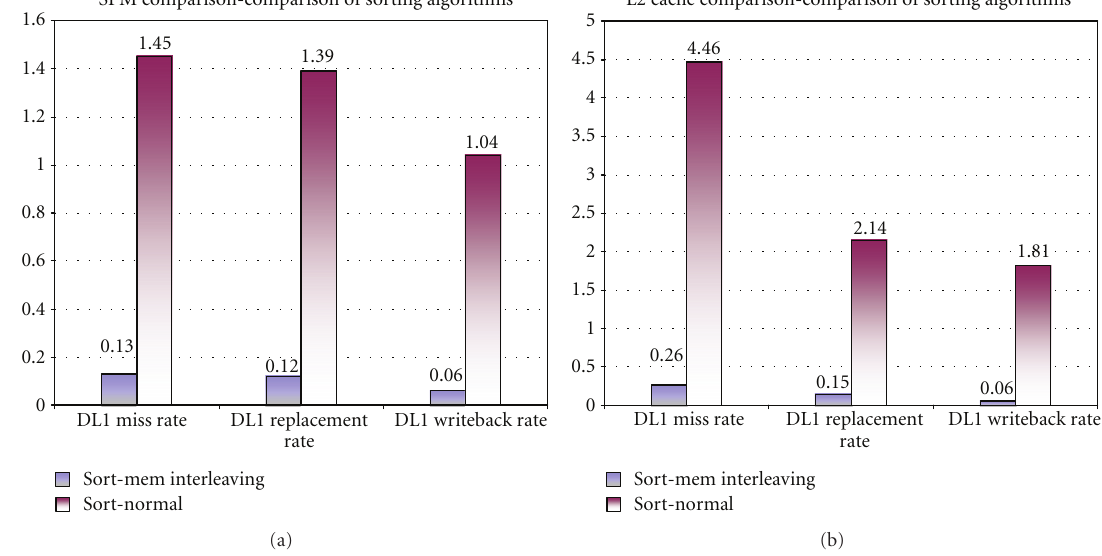
Figure 4: (a) SPM and (b) L2 cache miss rate, replacement rate and, writeback